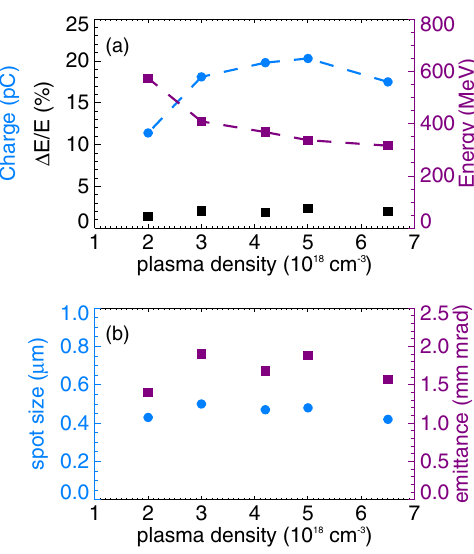
FIG. 3. (a) Variation of the trapped charge (blue circles, left axis), energy (purple squares, right axis), and rms energy spread (black squares, left axis) as a function of the plasma density when the laser dimensions are kept constant. (b) Variation of the electron beam rms radius (blue circles, left axis) and emittance (purple squares, right axis) as a function of plasma density.